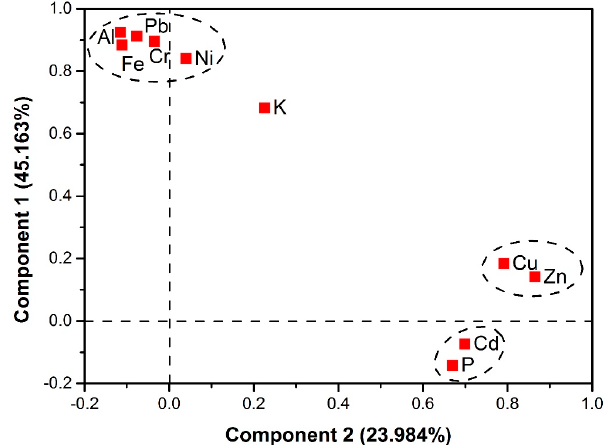
Figure 4. Factor loadings for two principal components after varimax rotation.